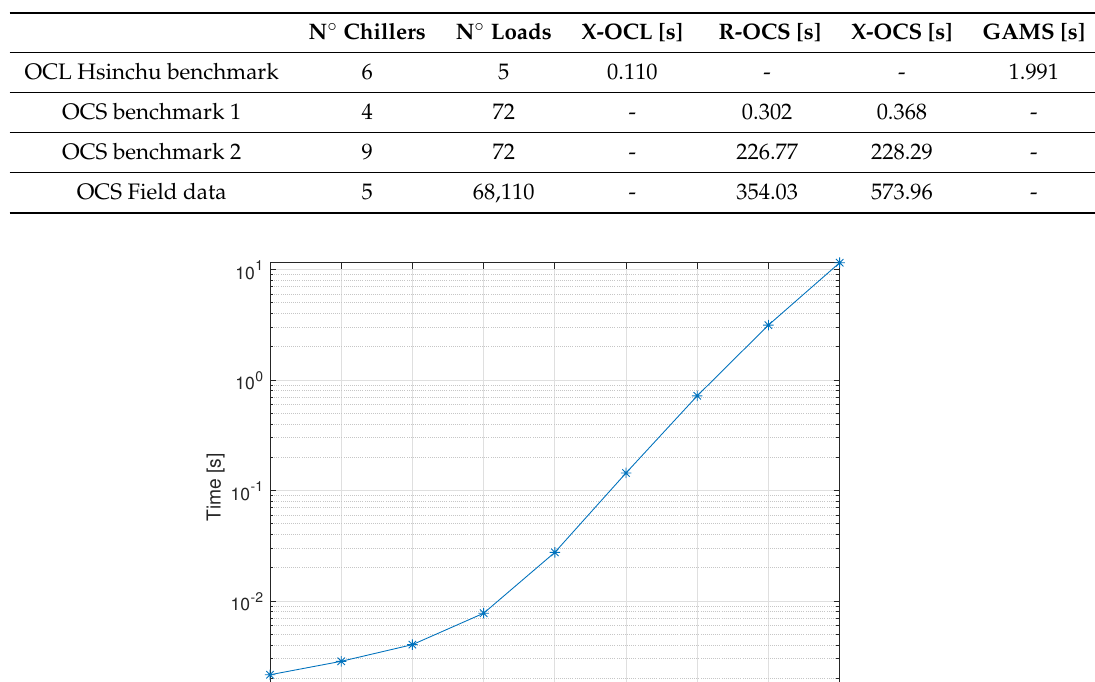
Table 7. Execution times for OCL and OSC benchmarks.